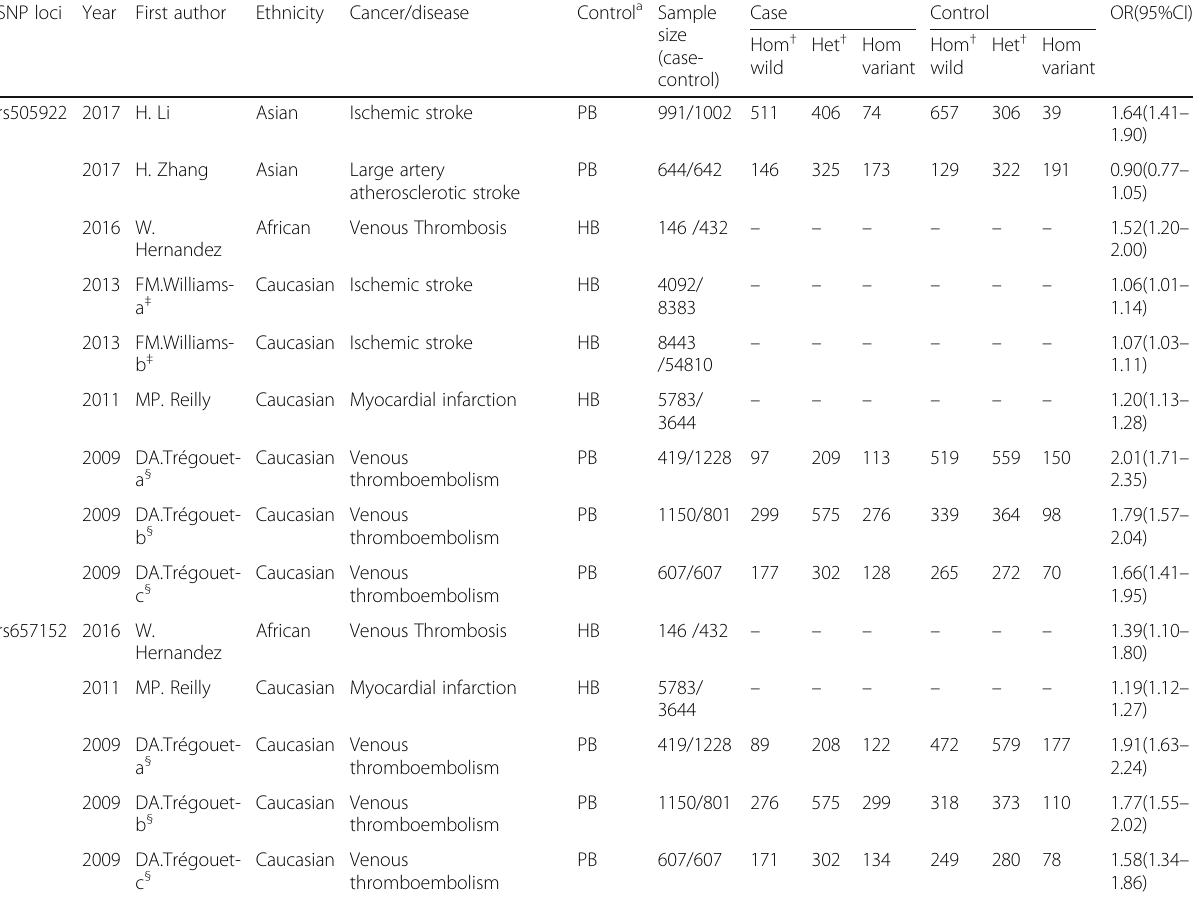
Table 2 Characteristics of the studies included in the meta-analysis of the association between SNPs and cardiocerebrovascular